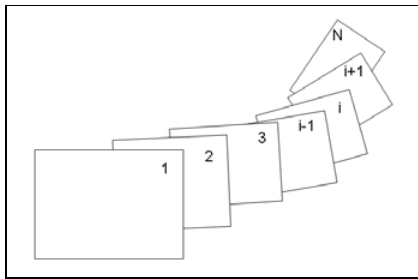
Figure 1. Mosaicing image appears a curled strip due to accumulation errors